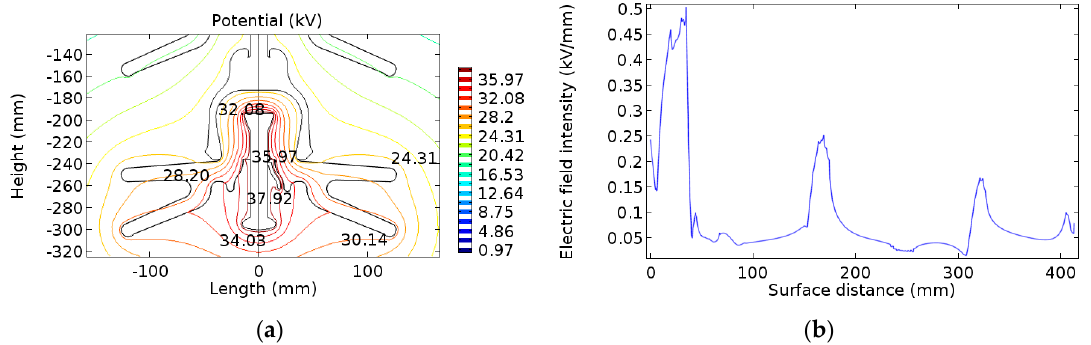
Figure 16. Simulation results of Extension 1: ( a ) equipotential line distribution; ( b ) electric field distribution along No. 1 insulator.